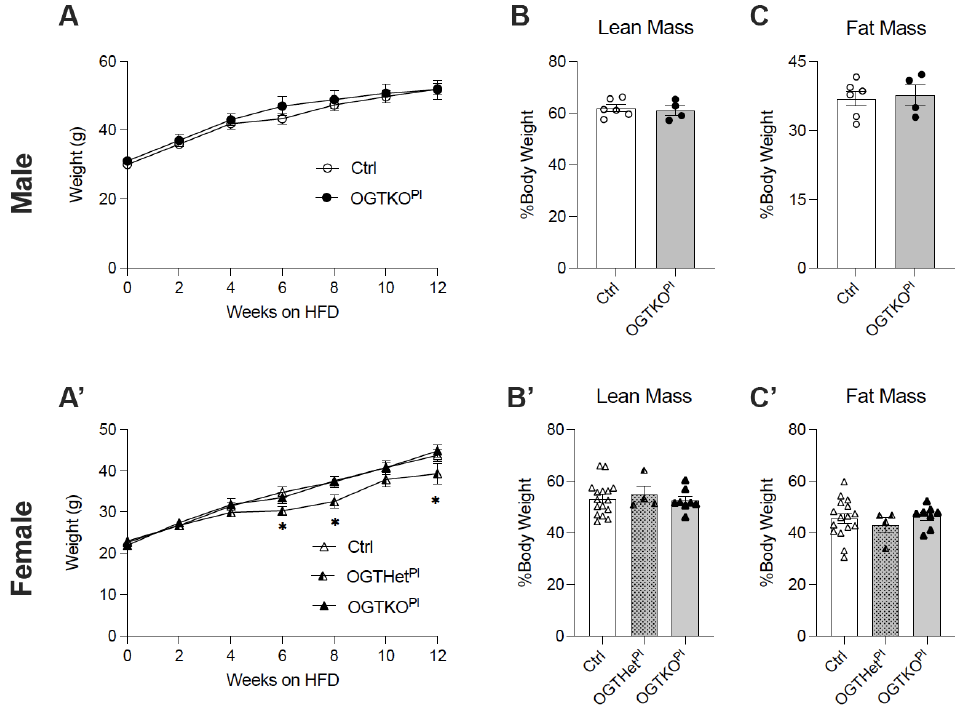
Figure 2. Placental OGT heterozygote females have decreased body weight starting at 6 weeks of HFD. ( A ) Body weight monitored across 12 weeks of HFD for males (n = 6, 7) and ( A’ ) females (n = 10, 17). ( B ) Lean mass of males (n = 4, 6) and ( B’ ) females (n = 4, 16) after 12 weeks HFD as assessed by EchoMRI. ( C ) Fat mass of males (n = 4, 6) and ( C’ ) females (n = 4, 16) after 12 weeks HFD as assessed by EchoMRI. ( A ) was presented as mean ± SEM, two-way ANOVA. ( B , C ) were presented as mean ± SEM, unpaired t -test for males and one-way ANOVA for females. p values, * p < 0.05.